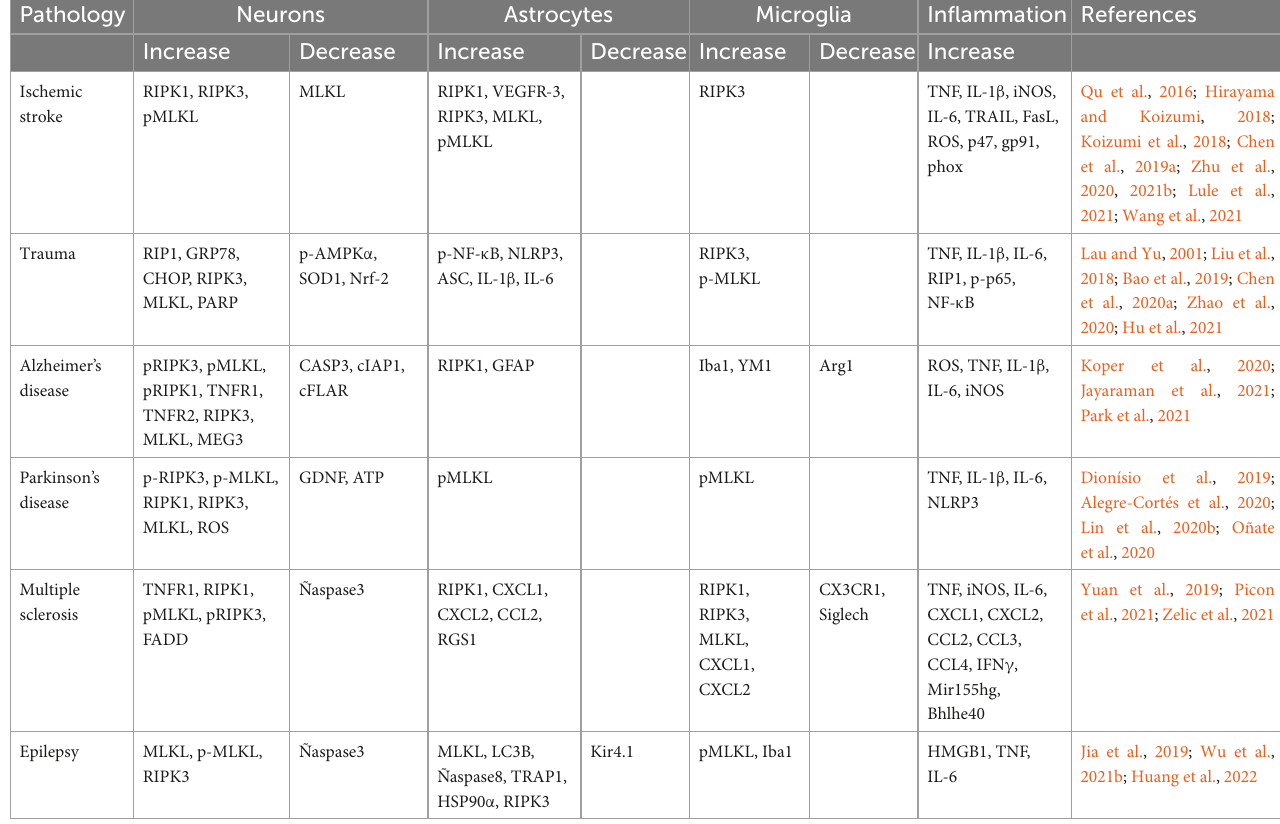
TABLE 1 Dynamics of the components of the necroptosis pathways involved in various CNS